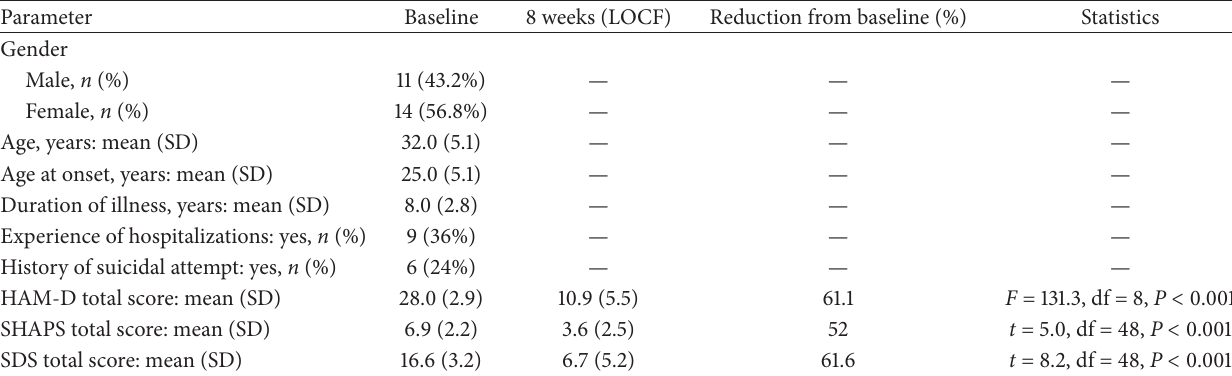
Table 1: Demographic and clinical data of study participants.